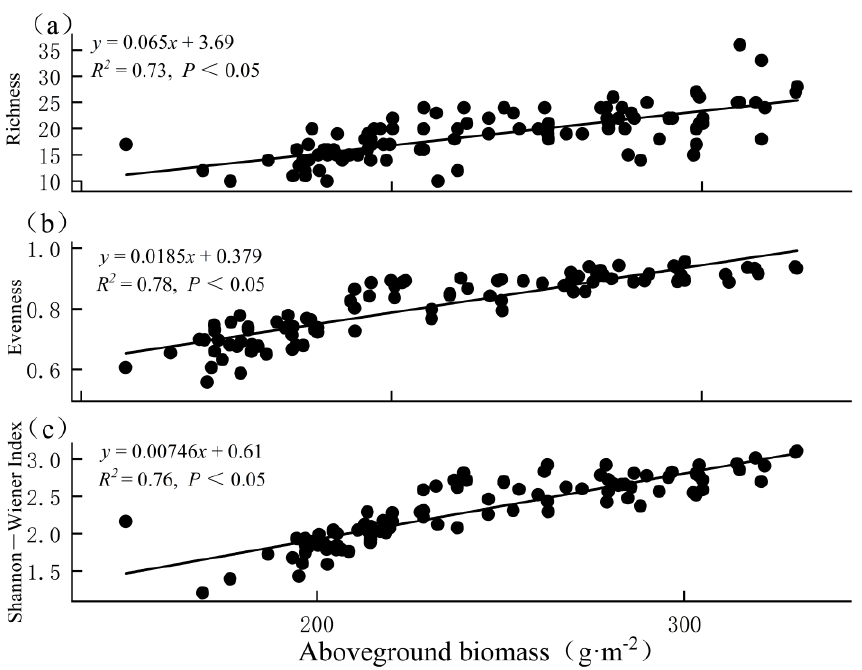
Figure 6. Relationships between aboveground biomass and ( a ) richness, ( b ) evenness, and ( c ) Shannon − Wiener index across 99 plots in GK, KH, and KP.